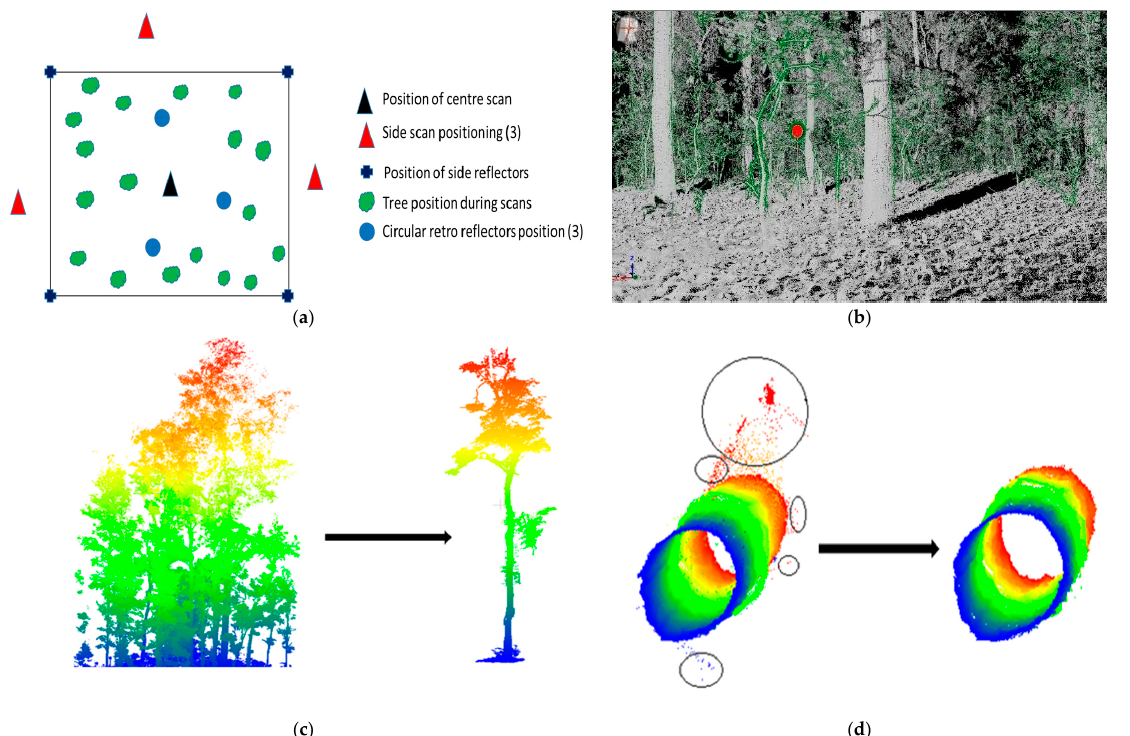
Figure 3. Representation of ( a ) scheme of the plot scanned with TLS and retro-reflectors; ( b ) scanned plot with the location of reflectors (red dot); ( c ) extracted plot and single tree; and ( d ) trunk of the tree with noise, and after the application of a noise filter [23].